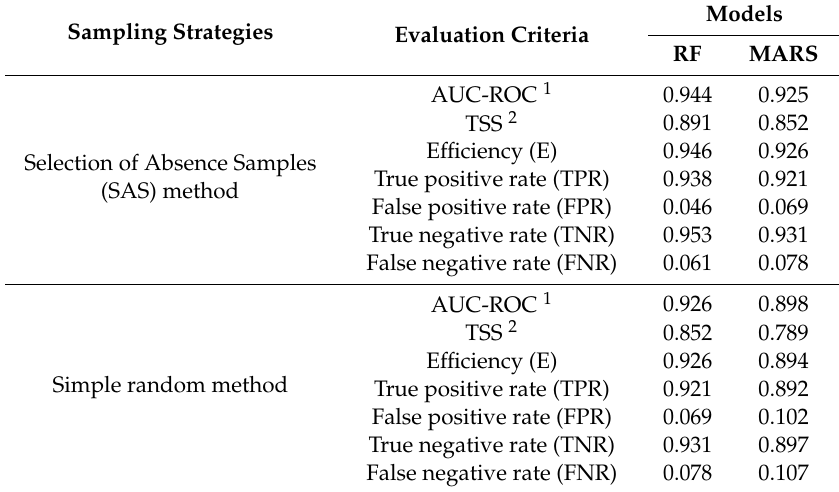
Table 5. Goodness-of-fit of the random forest (RF) and multivariate adaptive regression splines (MARS) models in di ff erent sampling